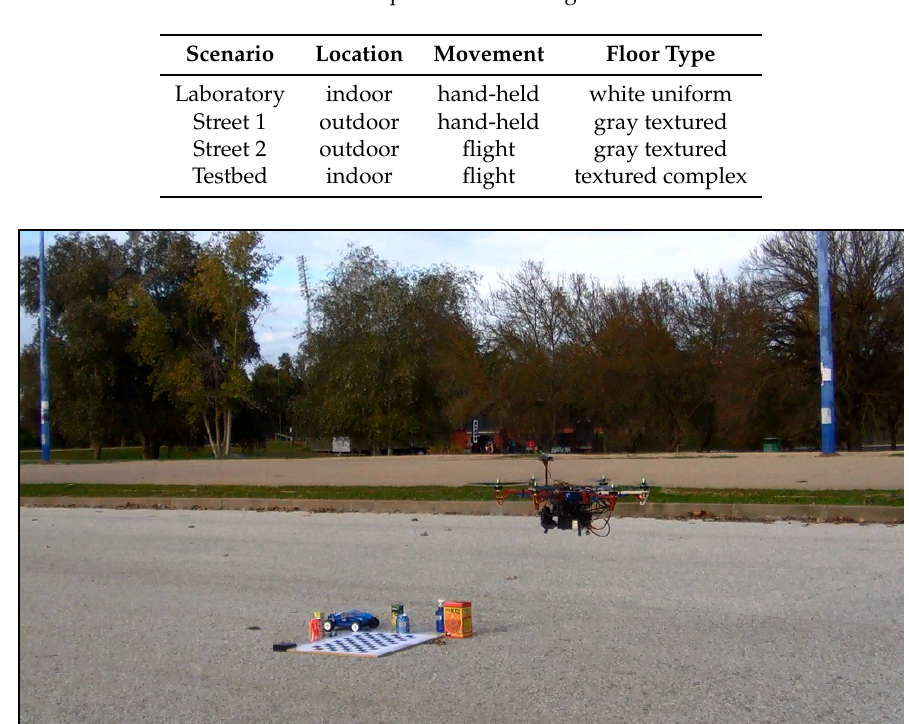
Figure 8. The drone flying above the objects during an outdoor experiment.